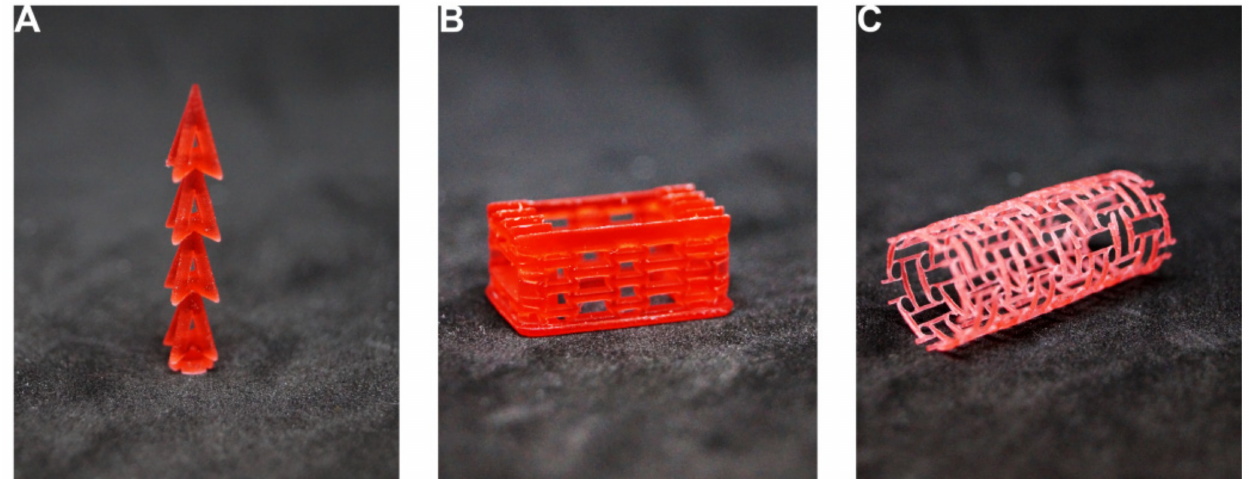
Figure 5. Examples of related prototypes of different medical devices benefiting from employing aux- etic units or having an auxetic geometry. ( A ) Auxetic insert for enhanced surgical fixation. ( B ) Spine disc replacement made of auxetic lattices for biomimetic performance. ( C ) 2D auxetic geometry mapped upon a cylinder to obtain an auxetic stent with improved implantation and